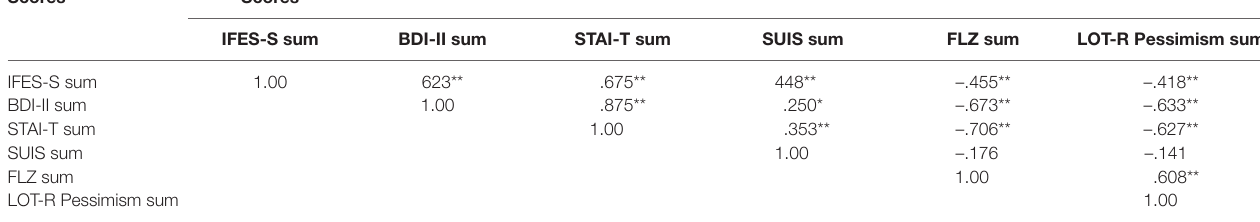
TABlE 2 | Zero-order correlations among IFES-S and BDI-II, STAI-T, SUIS, FLZ, and LOT-R. Scores Scores IFES-S sum